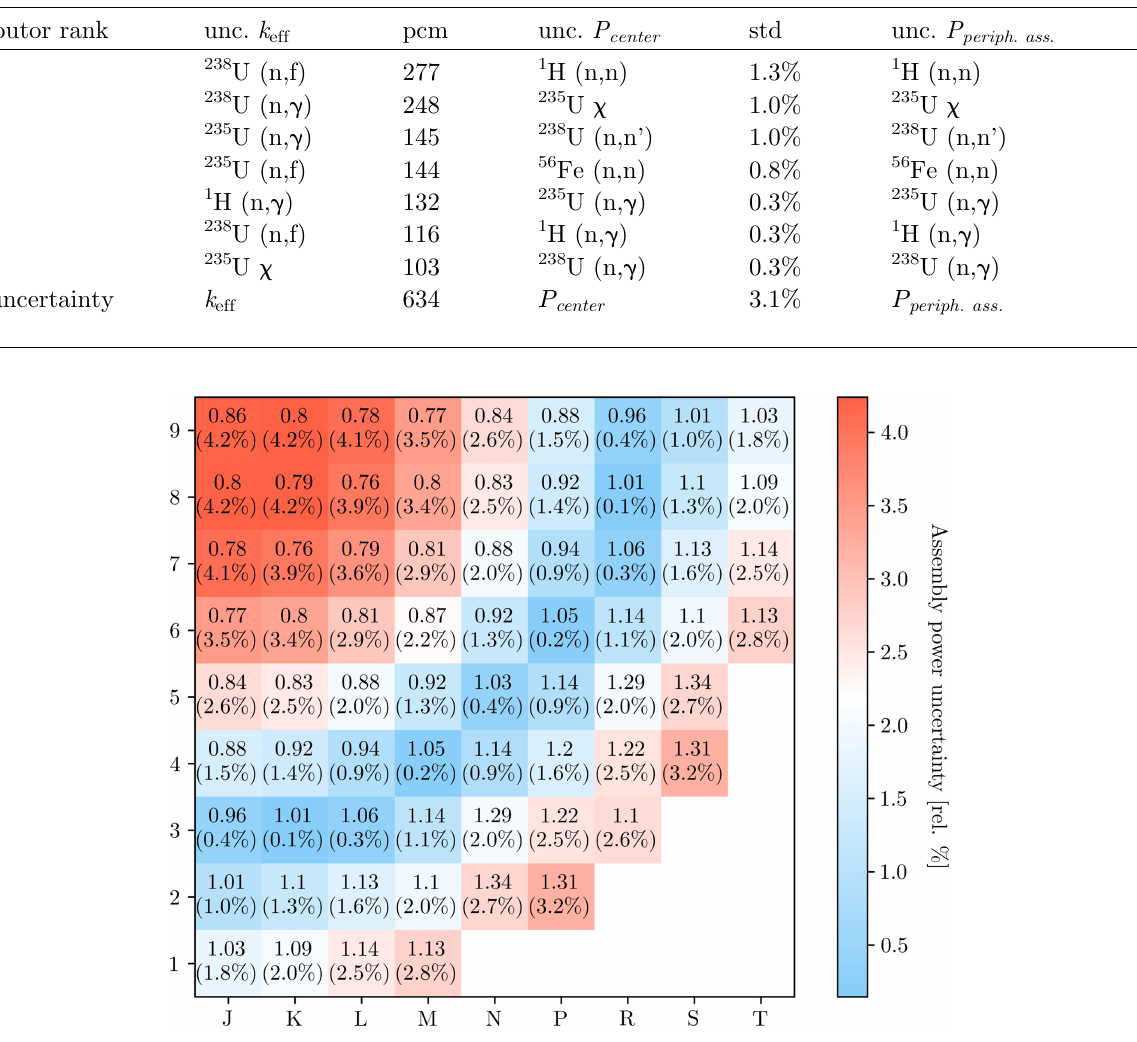
Table 3. Main contributors and total propagated uncertainty (1 s ) with COMAC-V2.